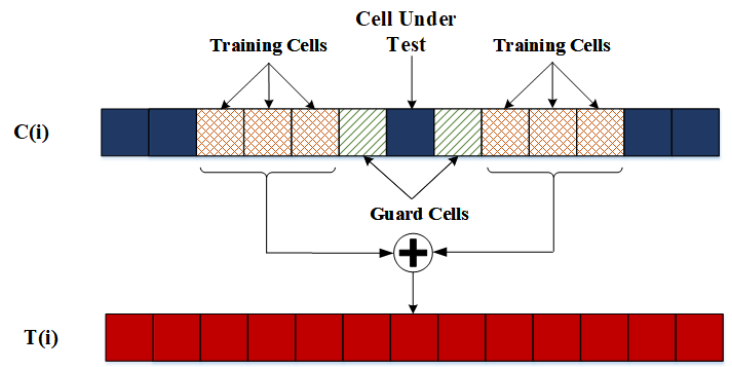
Figure 6. Diagram of a CFAR detection scheme.